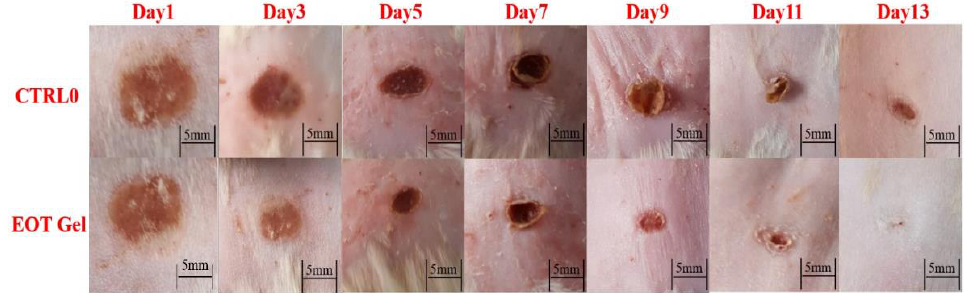
Figure 8. Evolution in time (contraction) of the wound healing process in both groups (the control group and the EOT hydrogel-treated group).